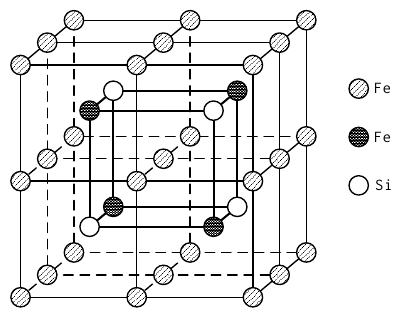
Figure 1. Schematic diagram of super cell structure of Fe 3 Si(DO3).